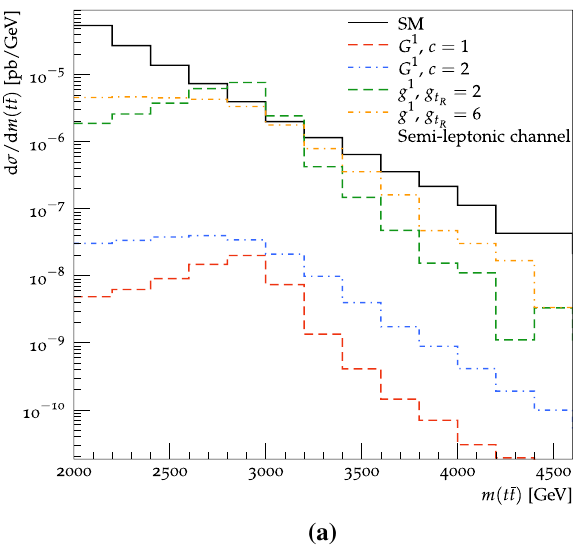
manages to reconstruct peaks for the narrow signal models, whereas the di-leptonic one smears out all of the signal models into something